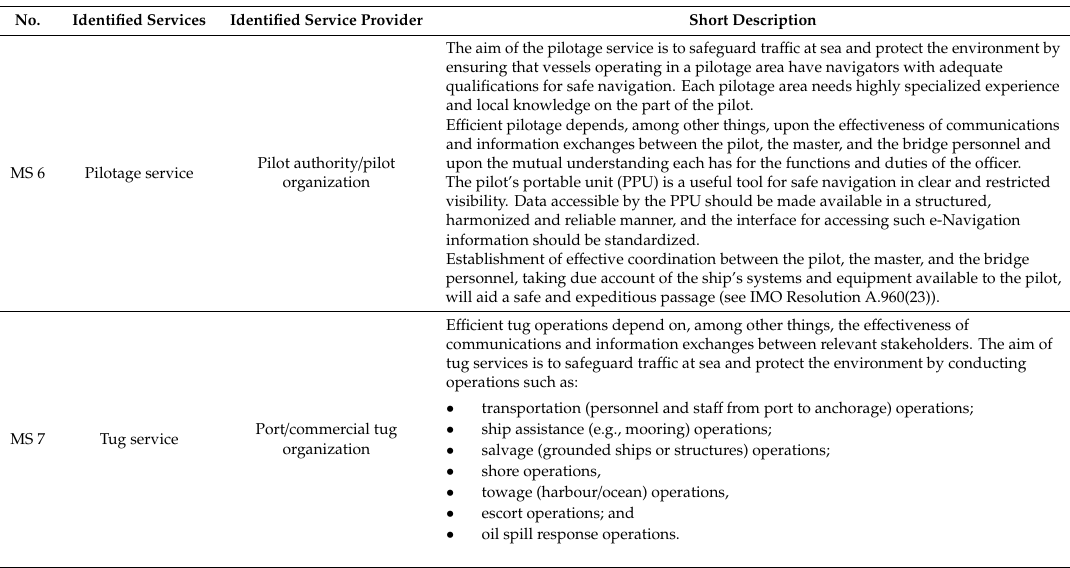
Table 7. Initial descriptions of pilotage and tug services